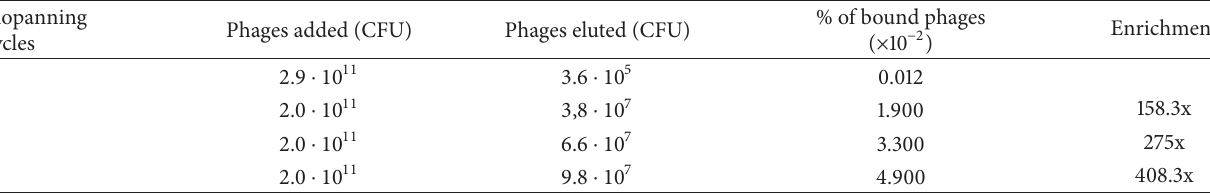
Table 1: Enrichment of anti- L. braziliensis IgG binding phage after four rounds of biopanning. The phages bound are expressed as the ratio of the phage output titer and the phage input titer.